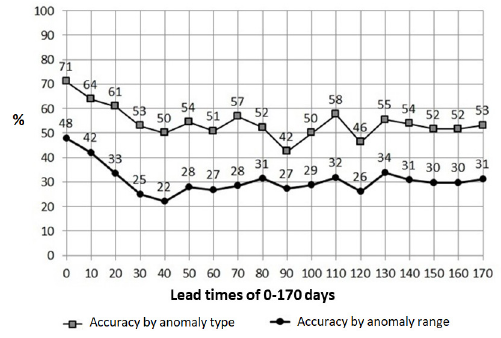
Figure 3. Accuracy (fractions of the correct forecasts in percent) of monthly-mean air temperature spatial anomaly forecasts generated using the CFSv2 model with different lead times for the territory of Lithuania